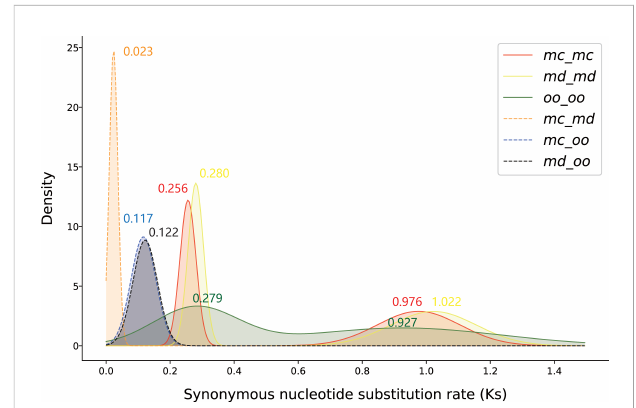
FIGURE 4 The frequency density distribution of synonymous substitution rate (Ks) of paralogous gene pairs in the syntenic blocks within, and orthologous gene pairs between, the three species, Melastoma candidum , M. dodecandrum and Osbeckia opipara. The values of Ks peaks are labeled. mc, Melastoma candidum ; md, M. dodecandrum ; oo, Osbeckia opipara .